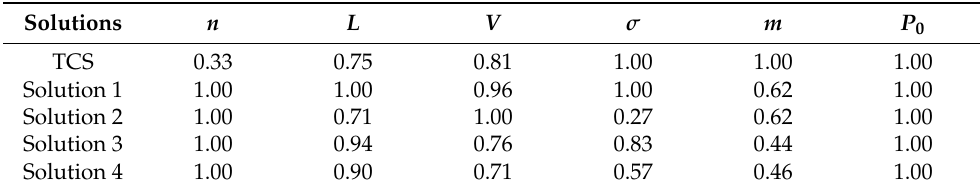
Table 4. Normalized parameter values of four TBM ICSs and the TCS.